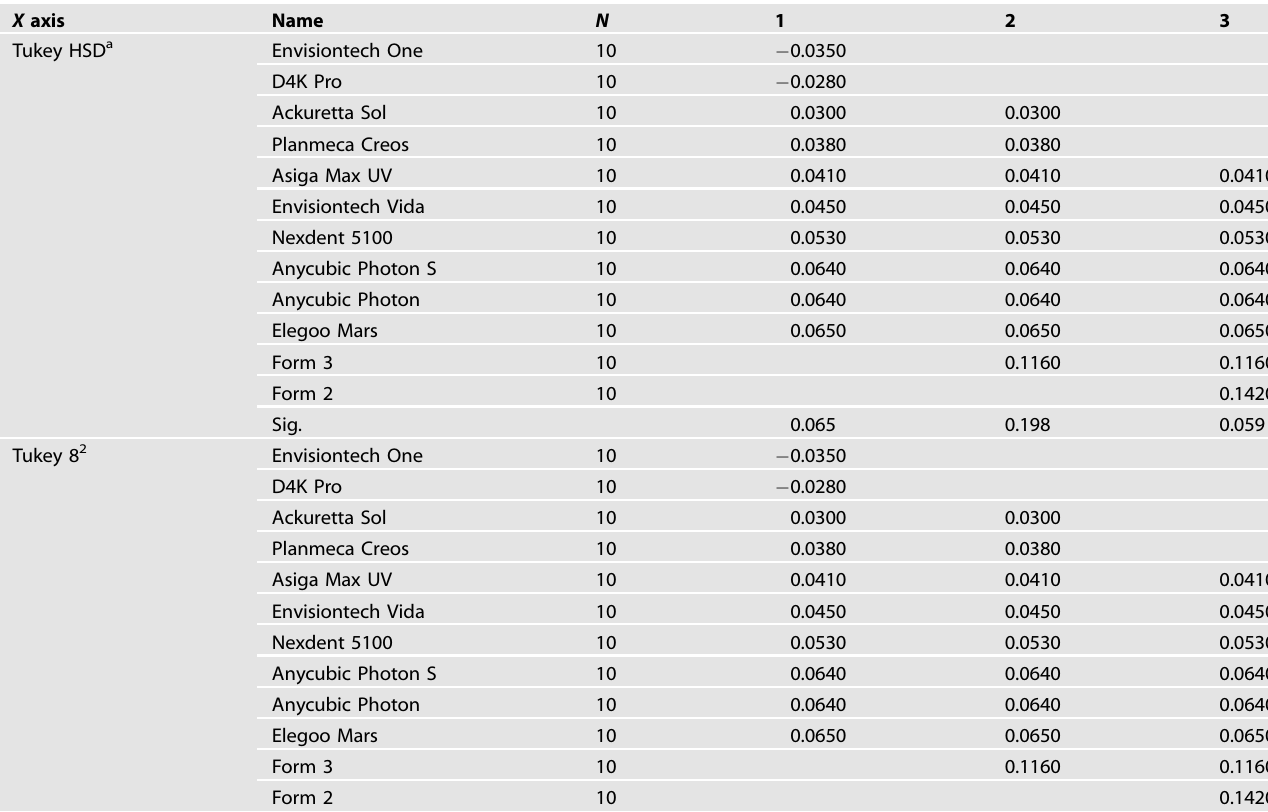
Table 3. Tukey homogenous subsets of compared means for the X measurement (subset for alpha =